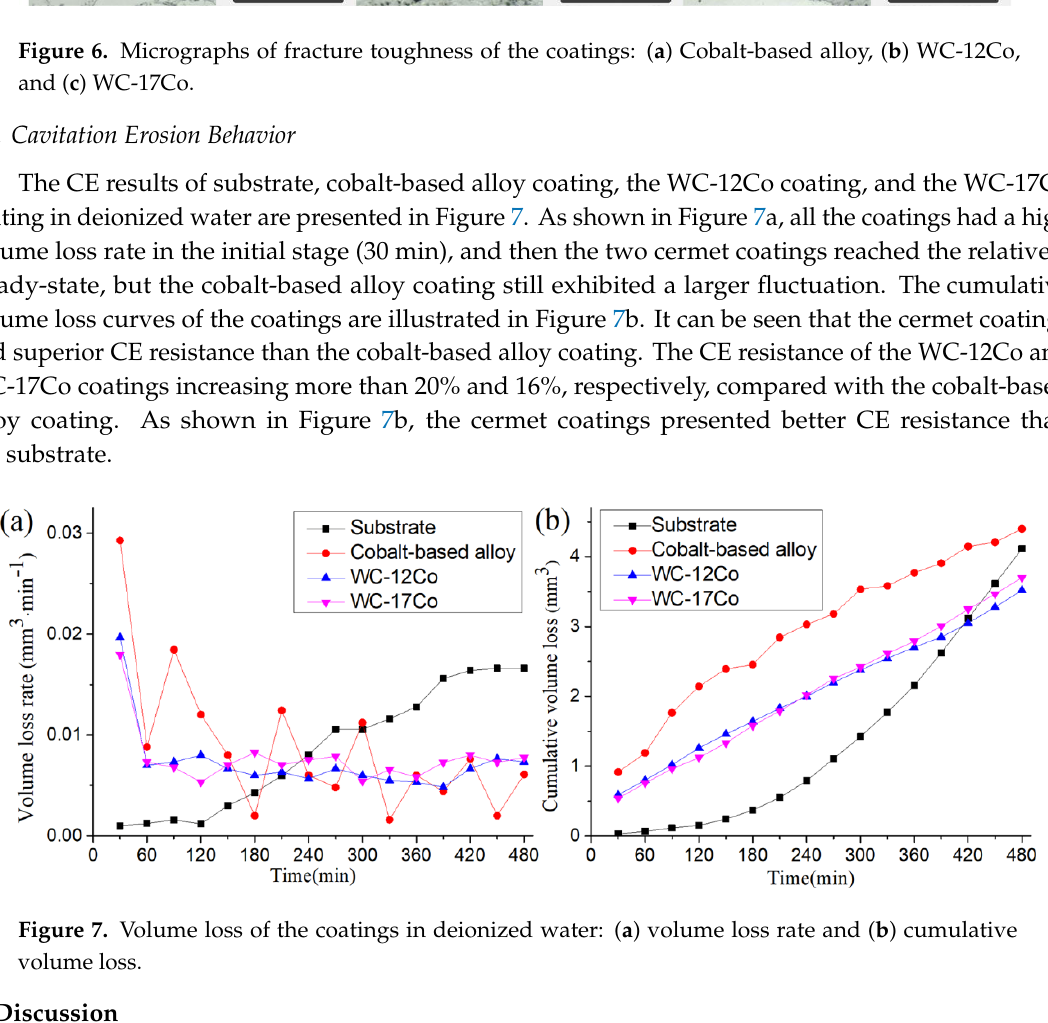
Figure 6. Micrographs of fracture toughness of the coatings: ( a ) Cobalt-based alloy, ( b ) WC-12Co, and ( c ) WC-17Co.